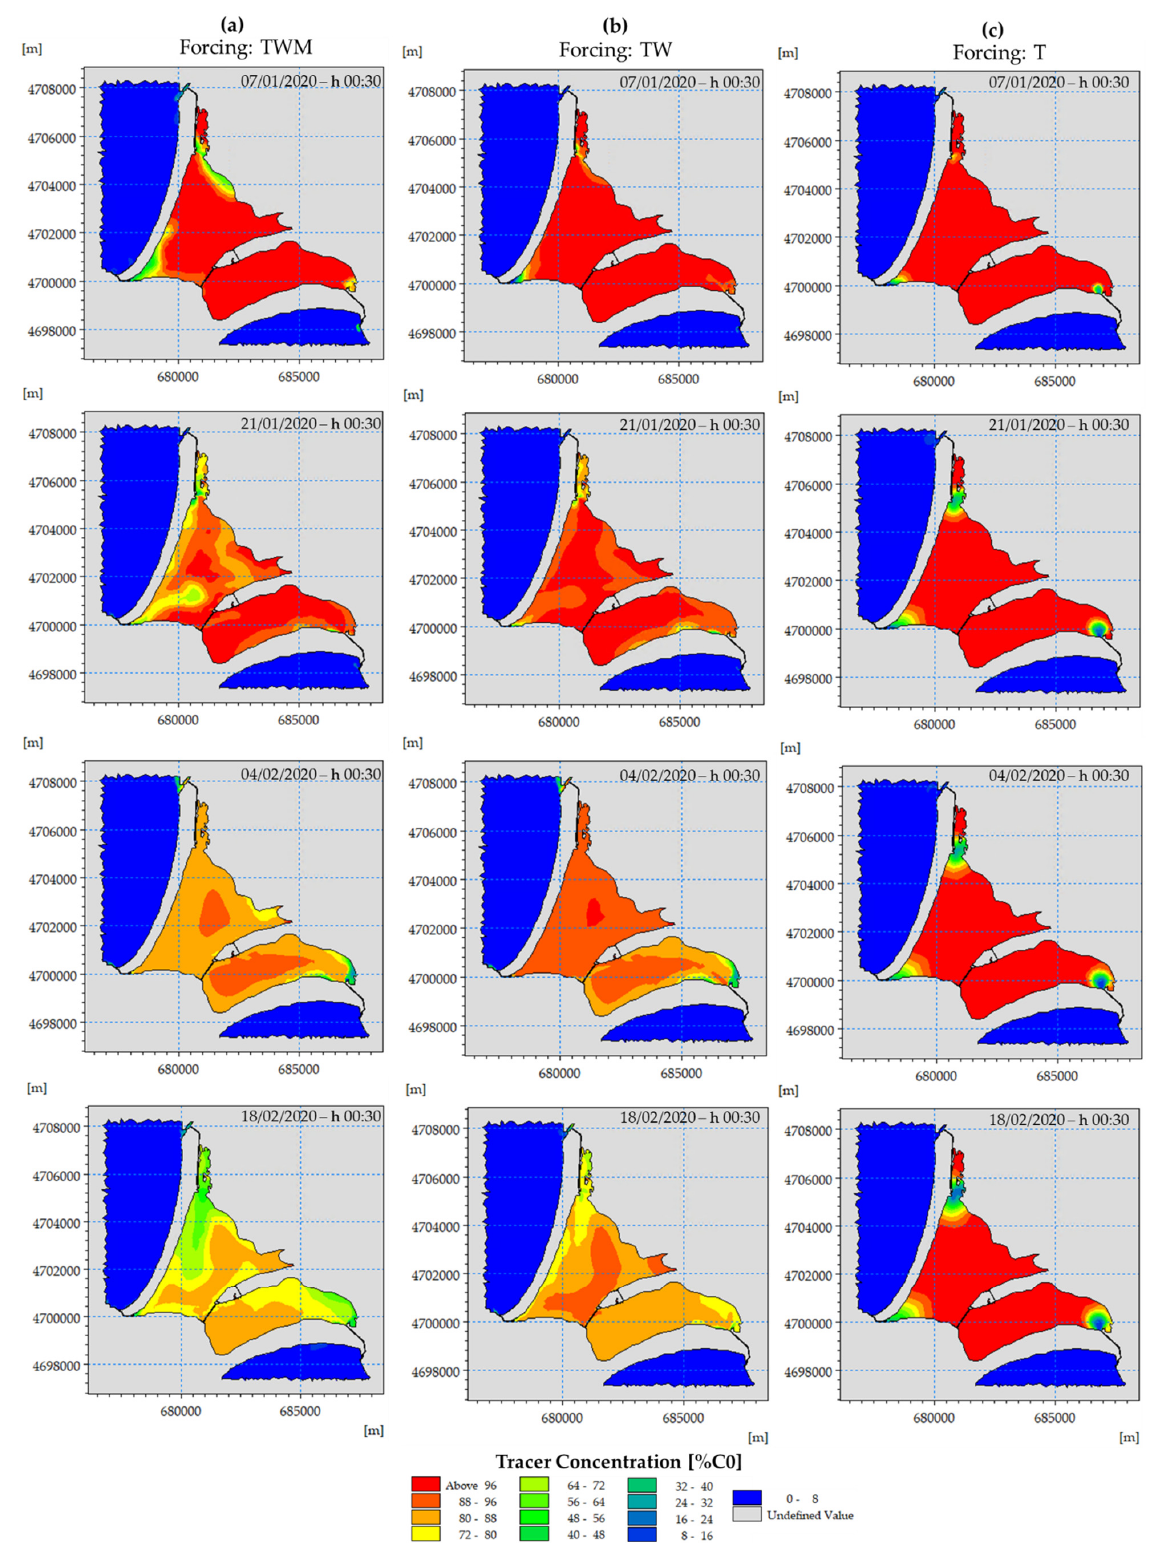
Figure 9. Comparison of the tracer concentration in the lagoon (expressed as percentage of the initial tracer concentration, C0) at the same instant in time in scenario PSOI, under the forcing mechanisms of astronomical tide, wind, and meteorological tide (code TWM, ( a )), astronomical tide and wind (code TW, ( b )), and astronomical tide only (code T, ( c )).